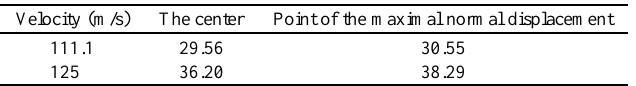
Table 2 The maximal normal displacement on inner surface (unit: mm)